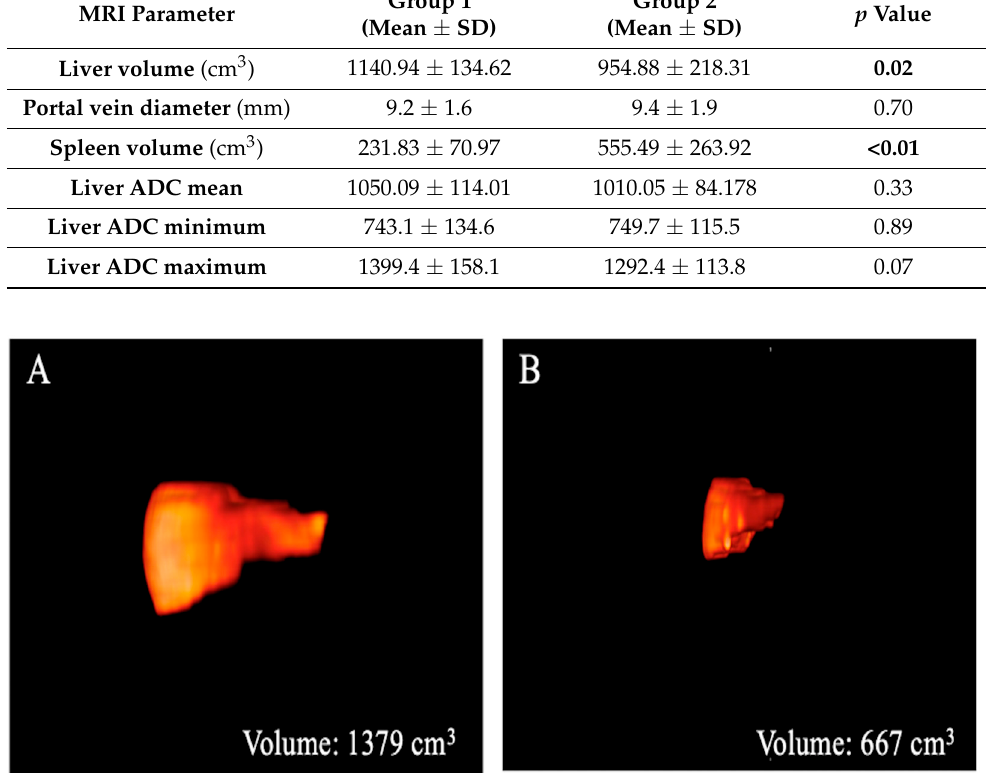
Figure 3. Three-dimensional volume renderings of the whole liver volumes as obtained from the T2-weighted axial sequence segmentation. The example shows a patient from Group 1 ( A ) with a greater volume compared to that from Group 2 ( B ).